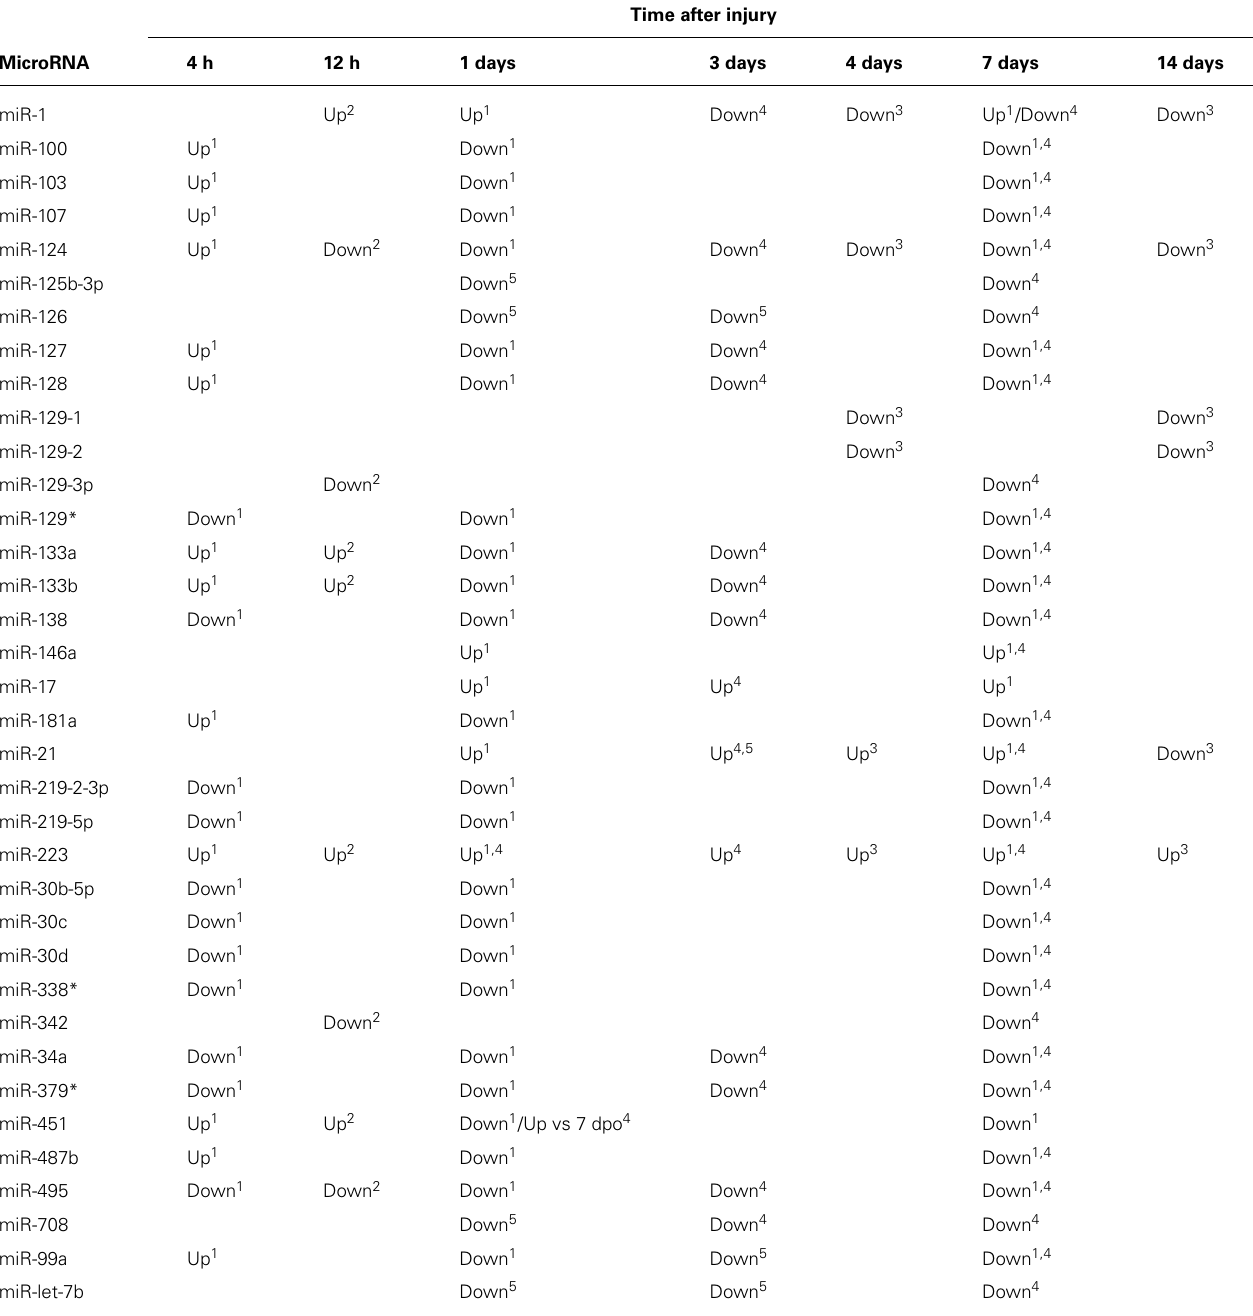
The table details the changes in microRNA expression following spinal cord injury of dysregulated microRNAs according to, at least, two different studies. Data derived from the following microarray analyses: 1 Liu etal. (2009); 2 Nakanishi etal. (2010); 3 Strickland etal. (2011); 4 Yunta etal. (2012); 5 Hu etal. (2013a,b). Unless stated, Up and Down correspond to upregulated and downregulated respect to Sham control individuals